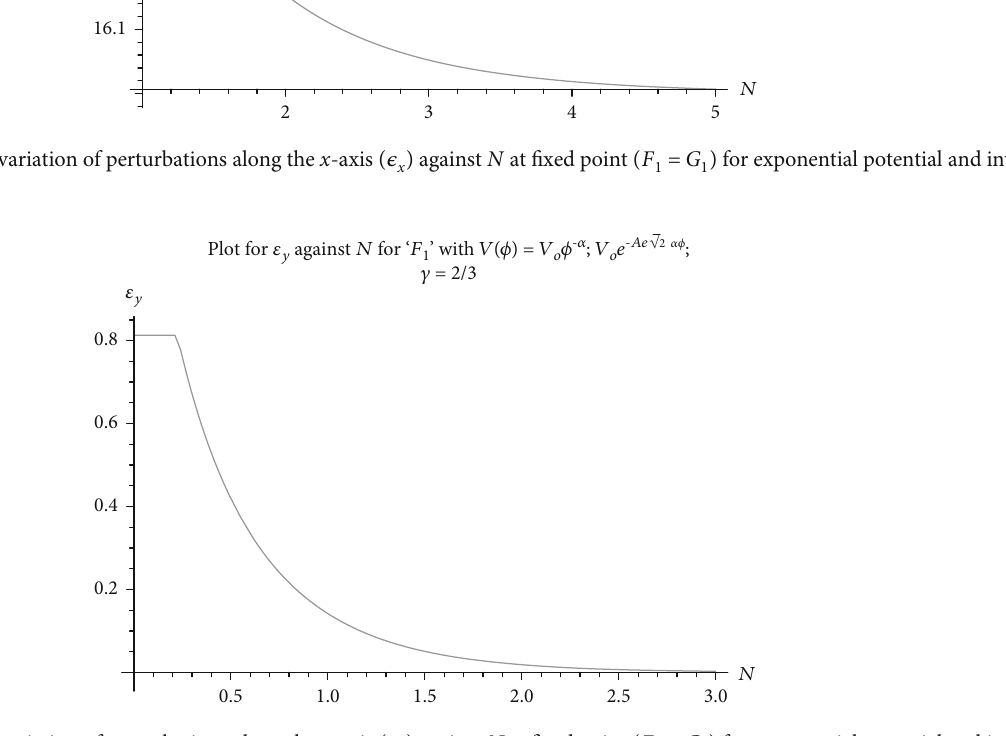
) against N at fi xed point ( F 1 = G 1 ) for exponential potential and inverse y